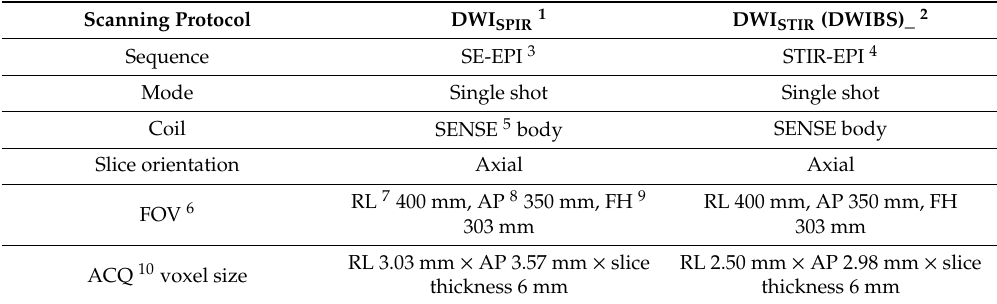
Table 1. Scanning parameters of DWI SPIR and DWI STIR techniques included in the MRE protocol. Scanning